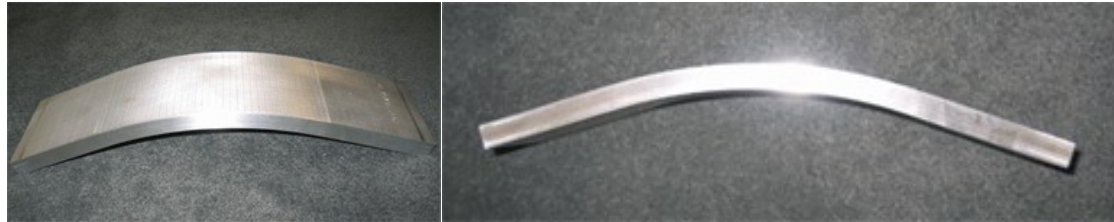
Figure 25. A 0.4 inch (10 mm) thick piece of Aluminum 7050 formed by laser peening [47].